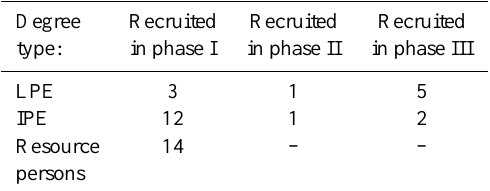
Table 2. Interview respondents in seven sub-groups based on their participation in local post-graduate education or international post- graduate education and their recruitment in one of the phases (phase I=1970–1987, phase II=1987–1998, and phase III=1998–